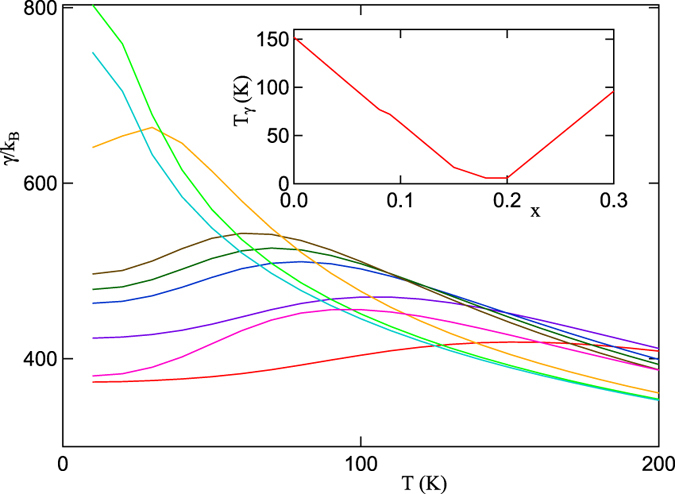
Sommerfeld constant calculated at several dopings.x = 0 (red curve), 0.05 (violet), 0.08 (blue), 0.09 (green), 0.10 (brown), 0.15 (orange), 0.18 (light green), 0.20 (light blue), and 0.30 (magenta). Inset: Tγ vs doping.